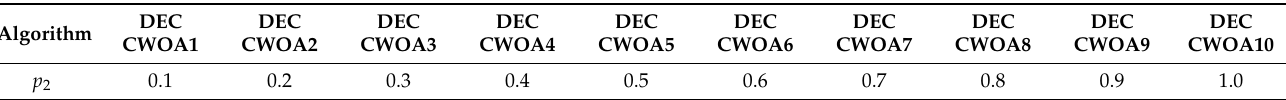
Table 2. Names of different algorithm versions when p 2 is